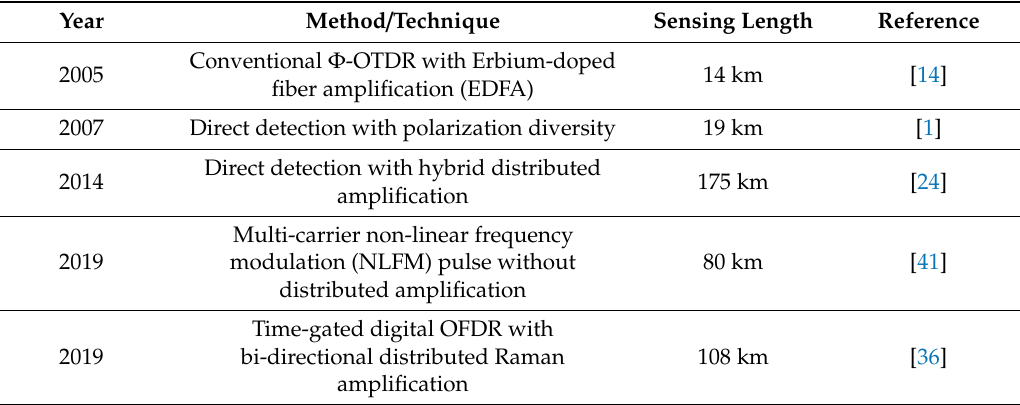
Table 3. Typical response bandwidth with di ff erent methods.